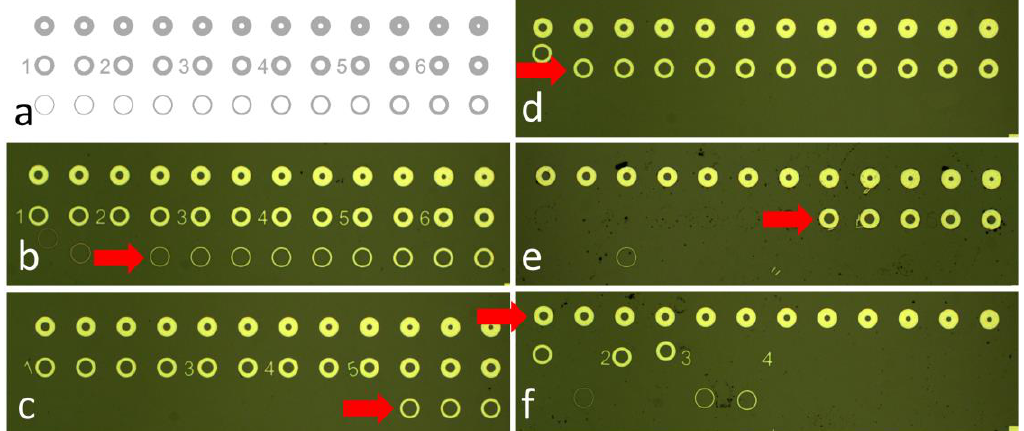
Figure 1. Test structure to determine the SiO 2 etch via lateral under etching. ( a ) Structure layout containing structures with identical outer diameter and different width starting from 2 µm and ending with 20 µm with step of 0.5 µm. Photographs of structures after SiO 2 etching for: ( b ) ≈1.5 min, ( c ) ≈3.0 min, ( d ) ≈4.5 min, ( e ) ≈6.0 min and ( f ) ≈7.5 min. The red arrow points at the torus shape with the smallest linewidth not fully undercut.